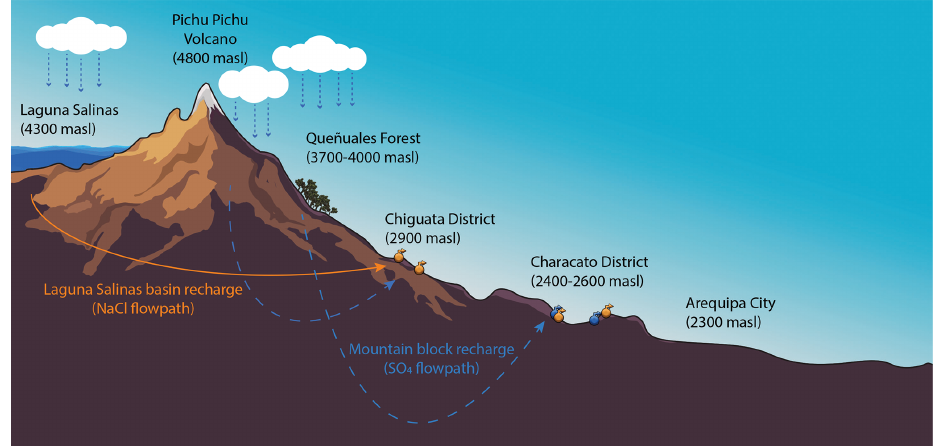
Figure 9. Cross section of our study area in the Quilca–Vitor–Chili basin, east of the city of Arequipa. Conceptual model identifying zones of recharge and flow paths in Characato (mountain block recharge (MBR) only) and Chiguata (salar basin recharge and MBR). Note that the conceptual groundwater flow paths do not cross (credit: Diego